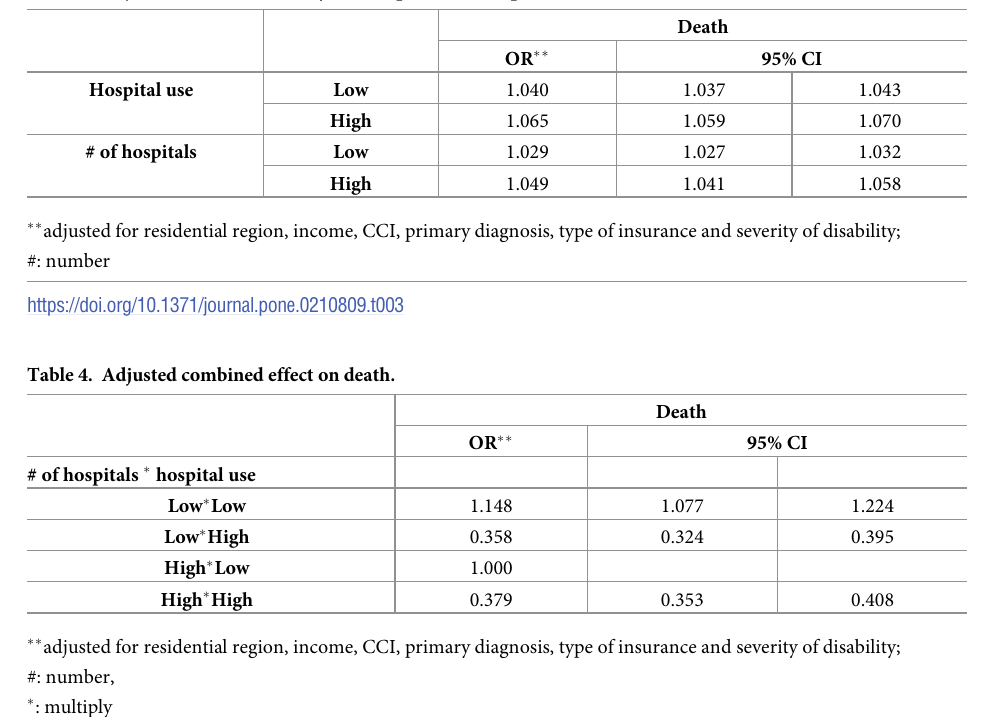
Table 3. Adjusted effect on death by # of hospitals and hospital